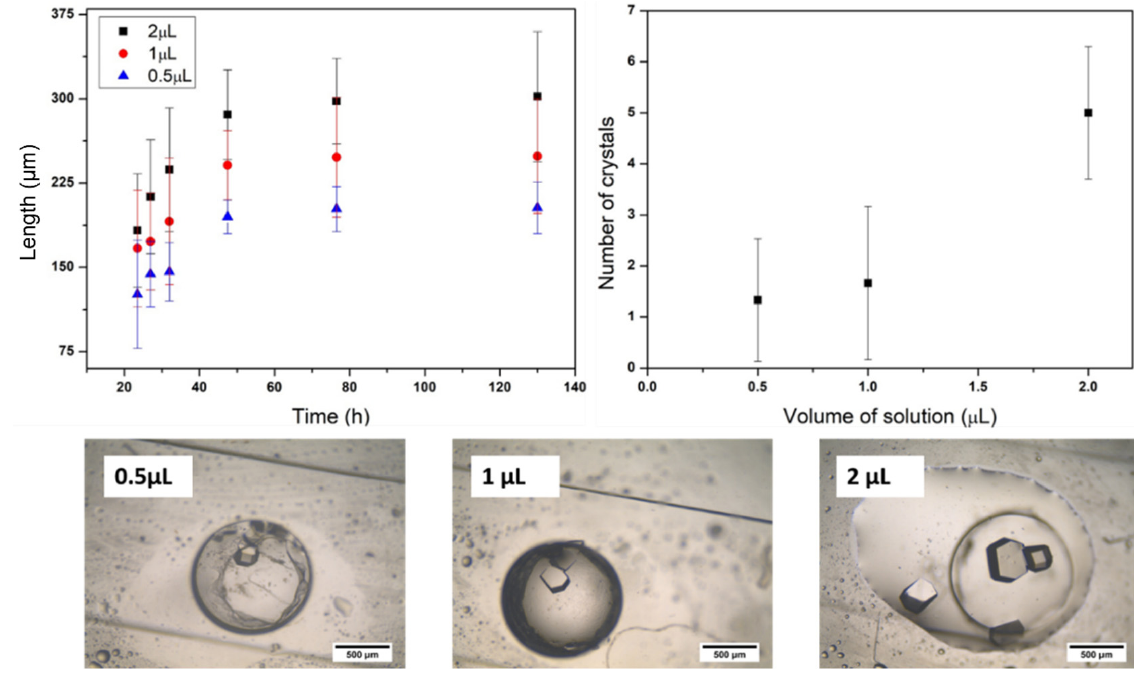
Figure 11. Crystal growth kinetics ( top left ) and the number of crystals per volume of solution ( top right ). On the bottom: crystals grown in different volumes of solution, observed after 130 h.